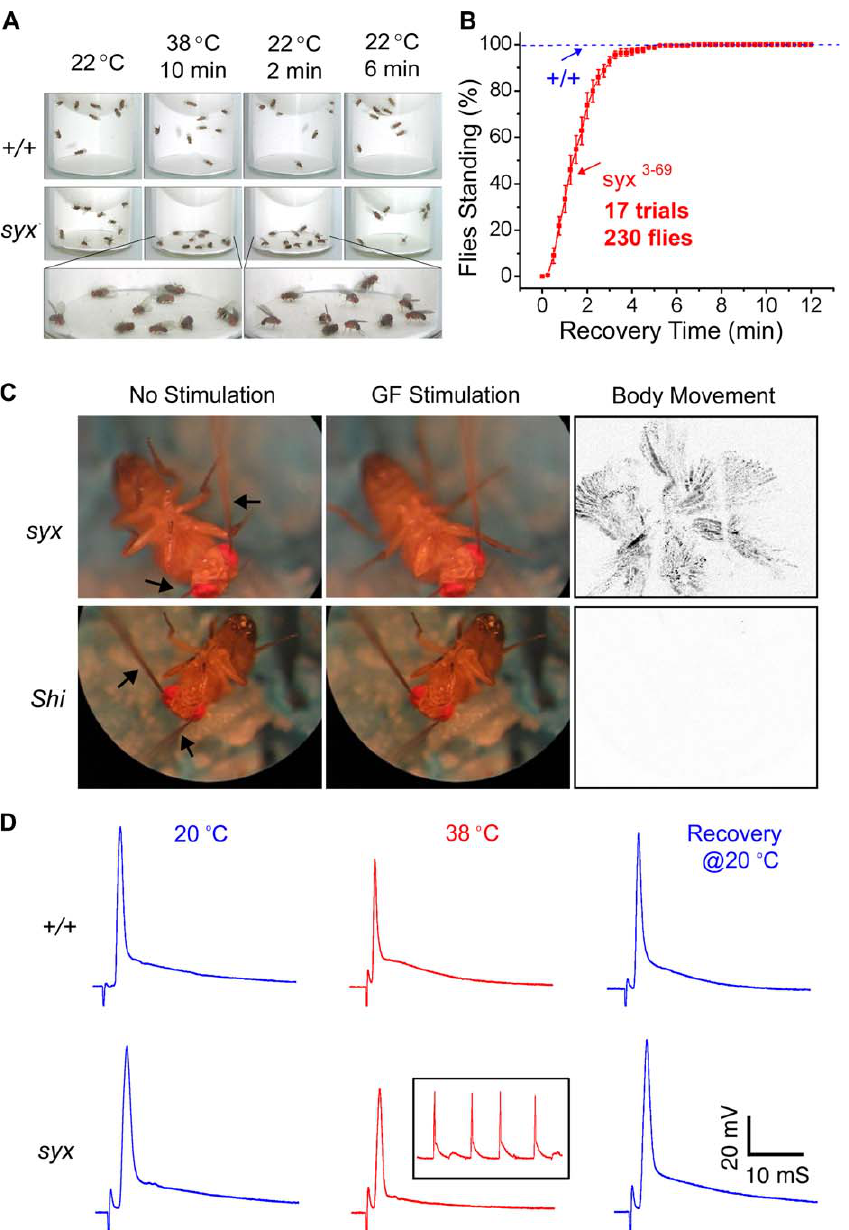
Figure 2. Behavioral and Electrophysiological Analyses Reveal That Synaptic Transmission Is Not Blocked in the syx 3–69 Mutant Fly at Restrictive Temperatures (A and B) Temperature-sensitive paralysis and recovery of the syx 3–69 mutant fly. (A) shows the still image of both wild type ( þ / þ ) and the syx 3–69 mutant before, during, and after exposure to the restrictive temperature (38 8 C). Although the wild-type flies are not paralyzed at 38 8 C, the syx 3–69 mutant flies are. However, the syx 3–69 flies recover rapidly to standing position within 2–3 min once returned to the permissive temperature. The quantification of the recovery kinetics is shown in (B). Error bars in this and all other figures indicate the standard errors. (C) The paralyzed syx 3–69 mutant flies remain capable of responding to stimuli via the polysynaptic giant fiber (GF) pathway. The flies are anchored on a glass slide upside down with modeling clay while a stimulating electrode is inserted into one of the compound eyes (arrows). The syx 3–69 fly constantly shakes its legs, head, and abdomen while paralyzed at 38 8 C. In response to electrical stimulation of the giant fiber neuron, the mutant fly extends its legs phase-locked with each stimulus. However, the Shi ts1 fly is completely paralyzed and does not respond to the stimuli at the same restrictive temperature. The right-most panels summarize the cumulative spontaneous and electrical stimulation–evoked movements of legs in syx 3–69 flies and the lack of leg movement in Shi ts1 flies. These behavioral observations strongly indicate that exposing the syx 3–69 fly to 38 8 C does not block synaptic transmission. See also Videos S4 and S5. (D) Recordings from indirect flight muscles confirm that synaptic transmission is not blocked in syx 3–69 flies at the restrictive temperature. Action potentials in DLMs driven by polysynaptic stimuli along the giant fiber pathway remain the same in the syx 3–69 mutant fly as in the wild-type control fly before, during, and after exposure to the restrictive temperature. Synaptic-induced high-frequency action potentials are often observed in both the wild type and the syx 3–69 mutant (unpublished data). These high-frequency action potentials also occur spontaneously in the mutant. (An example is shown in the inset